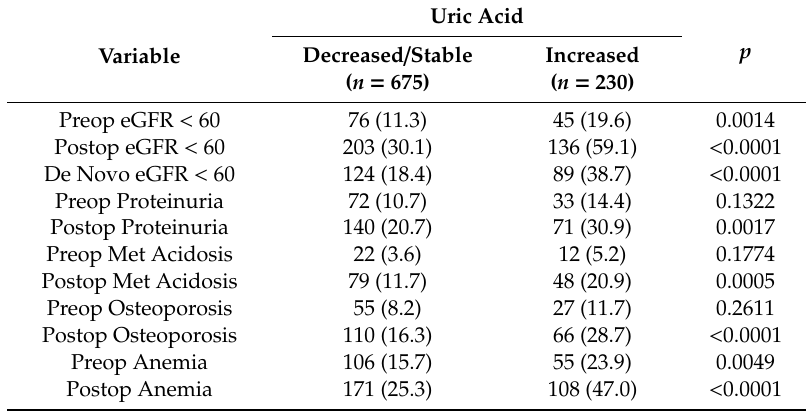
Table 2. Renal function and metabolic outcomes in the decreased / stable uric acid and increased uric acid